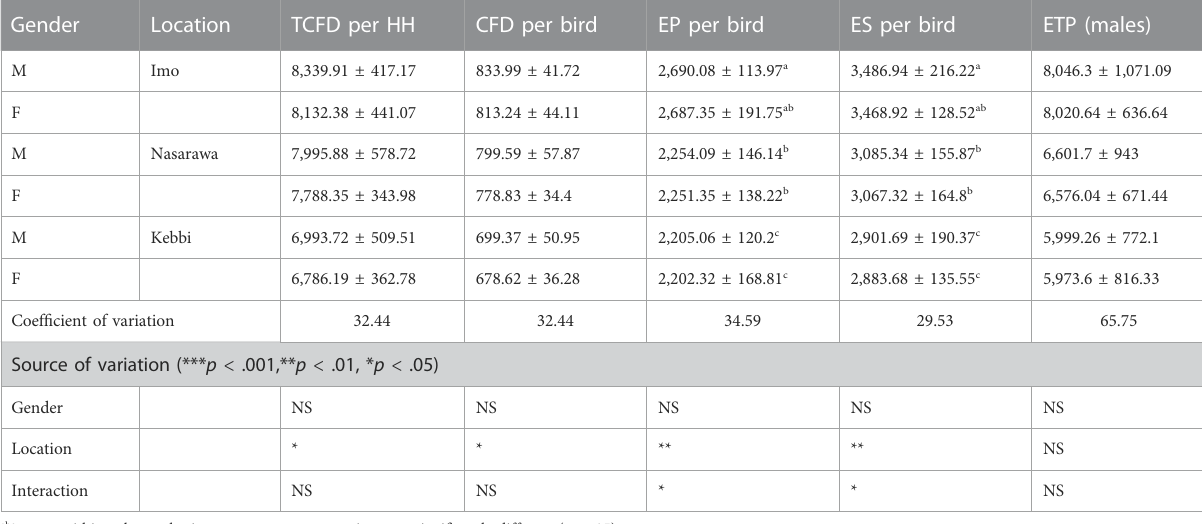
TABLE 9 Interaction effect of gender and location on pro fi tability (LSM ± SE) of the improved smallholder chicken intervention.